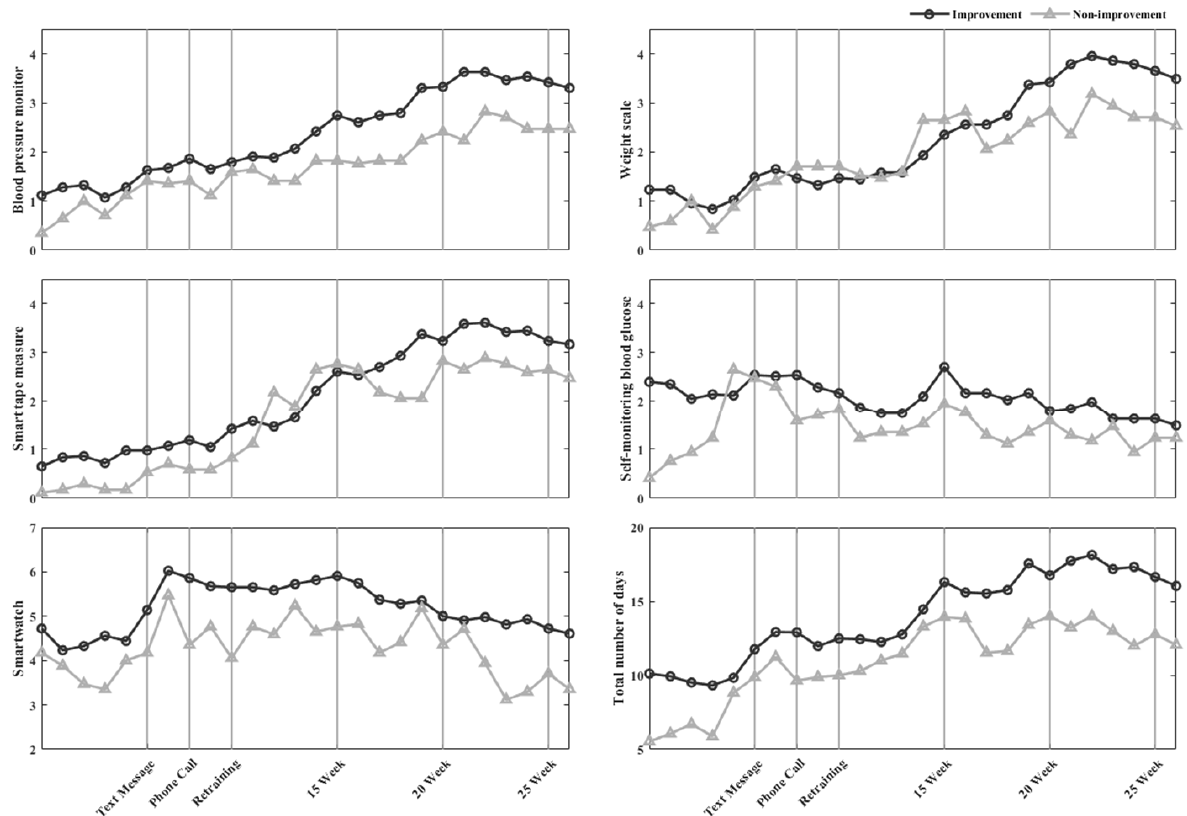
Figure 3. In MetS, the number of days healthcare devices were used per week.